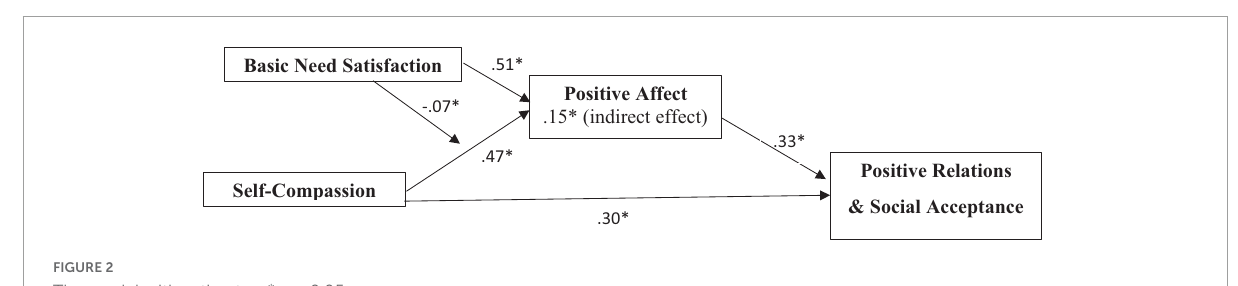
FIGURE2 The model with estimates. ∗ p <